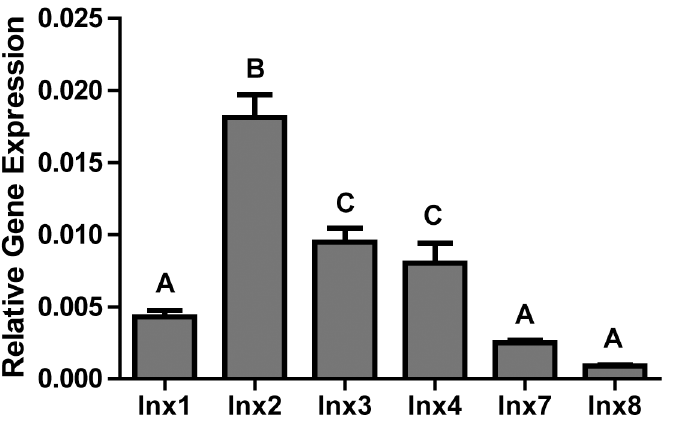
Fig 5. Relative innexin gene expression as normalized to RPS7 gene expression in eGFP dsRNA injected mosquitoes 3 days after injection. Values are means ± SEM. n = 4 replicates of 3 mosquitoes. Letters (A, B or C) indicate statistical differences as determined by a one-way ANOVA and Newman-Keuls post-test (P < 0.05).